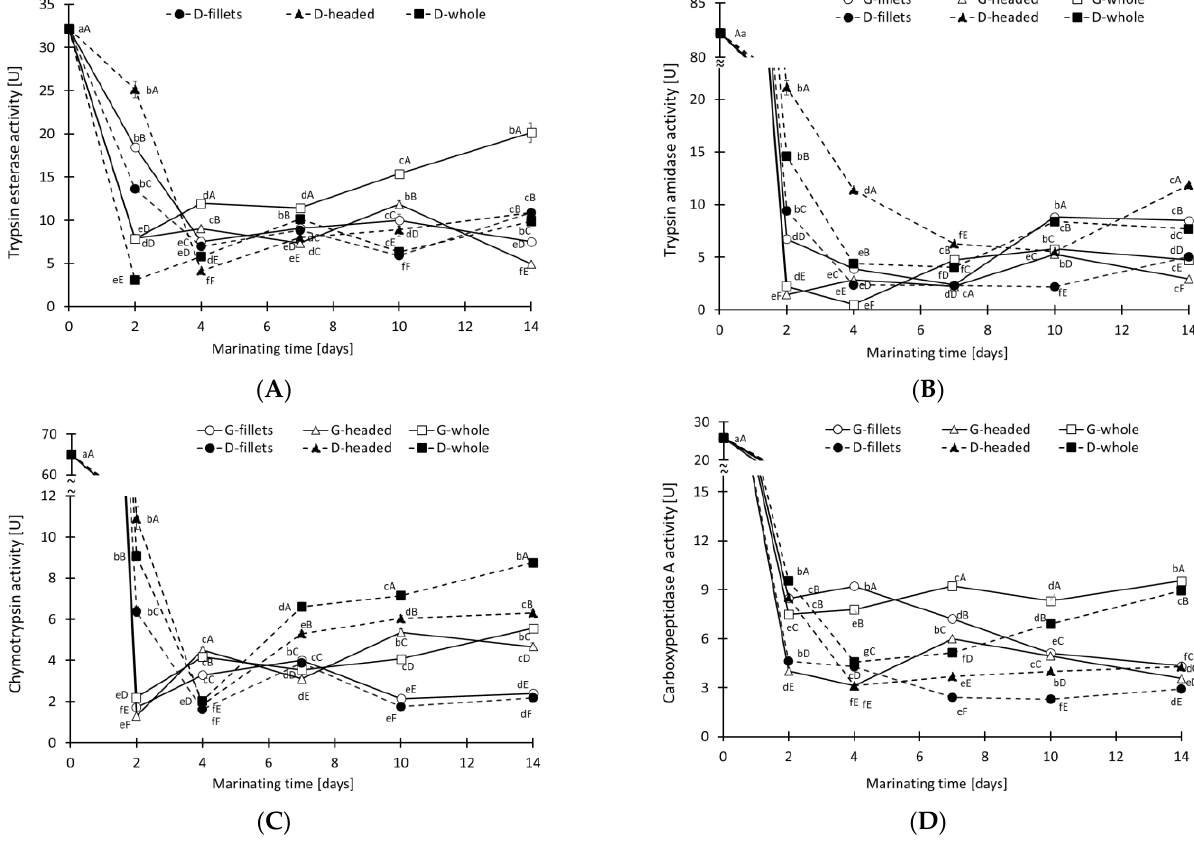
Figure 5. Effect of marinating method (G- — German, D- — Denmark) and degree of primary processing of Baltic herring (whole, headed, fillets) on activity of ( A ) trypsin esterase, ( B ) trypsin amidase, ( C ) chymotrypsin and ( D ) carboxypeptidase-A during marinating. a,b,c Results marked with the same lower case letter do not statistically differ by the influence of marinating time; A,B,C Results marked with the same capital letter do not statistically differ by the influence of the marinating method. For a better presentation of the results, a break (≈) in the Y axis was used.